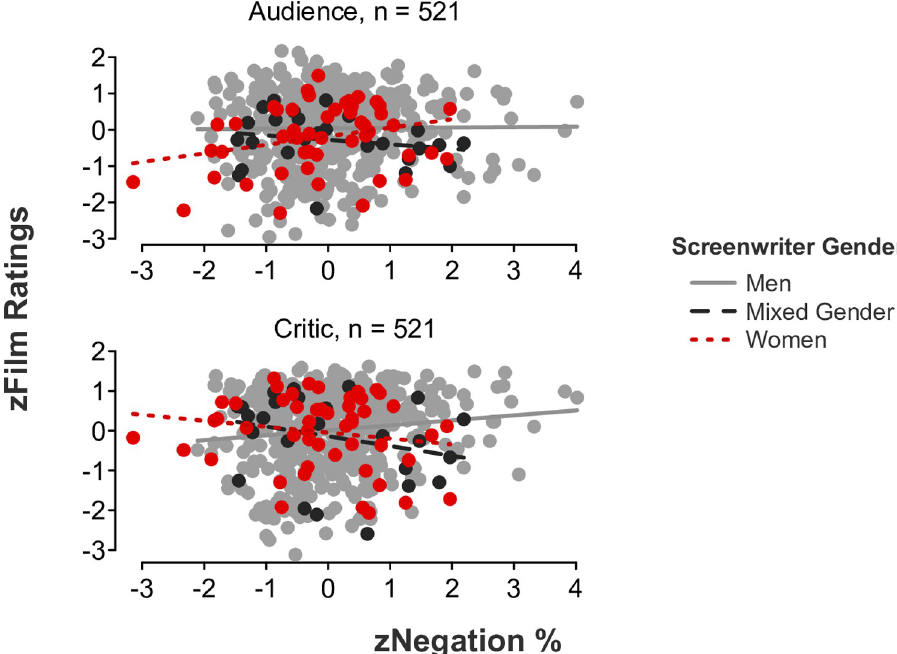
Fig 4. Film ratings as a function of negation use, screenwriter gender, and rater